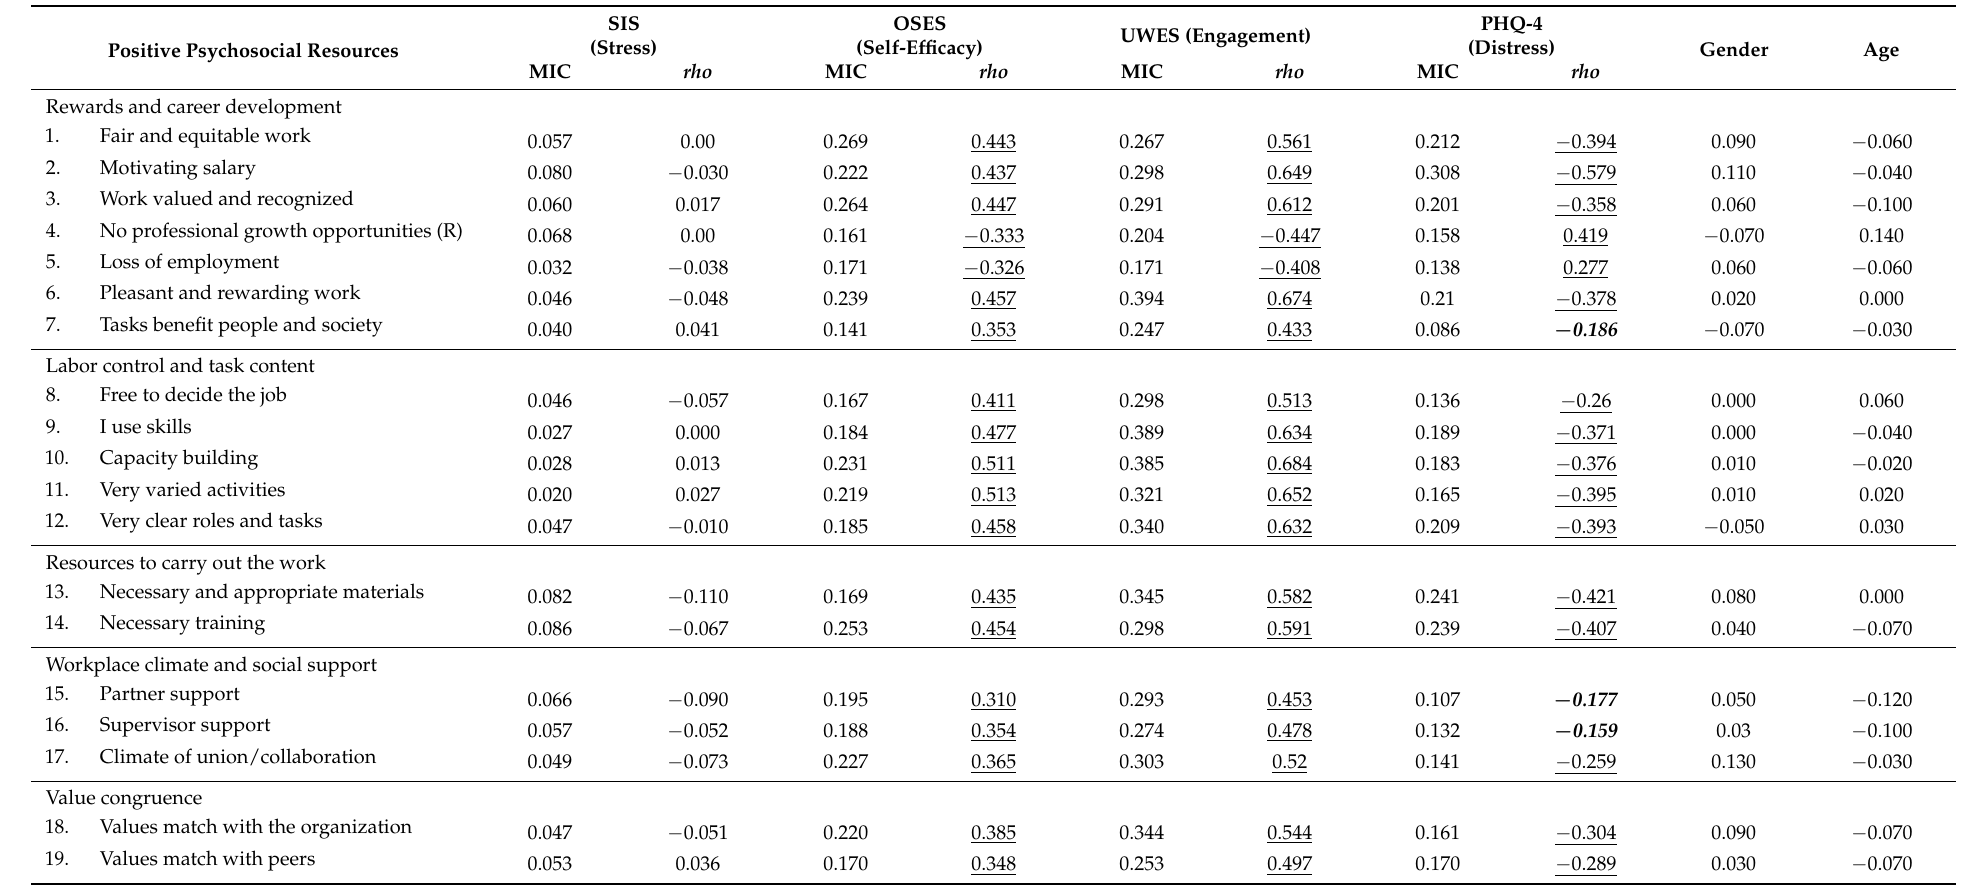
Table 5. Associative results of the psychosocial positive resource